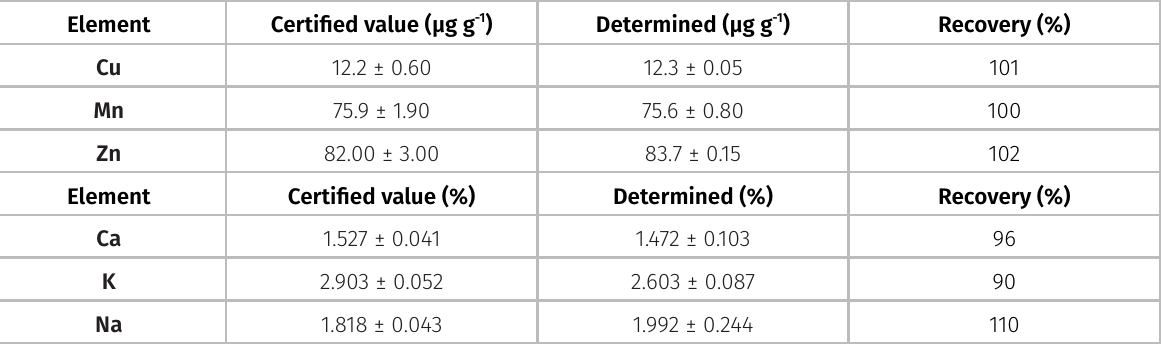
Table I. Analysis of spinach leaves (Certified Reference Material - CRM 1570a) by ICP OES after microwave